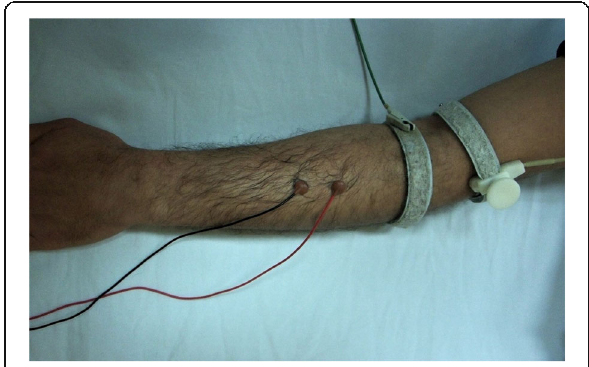
Fig. 1 Technique of posterior antebrachial cutaneous nerve sensory conduction study showing the stimulation and recording